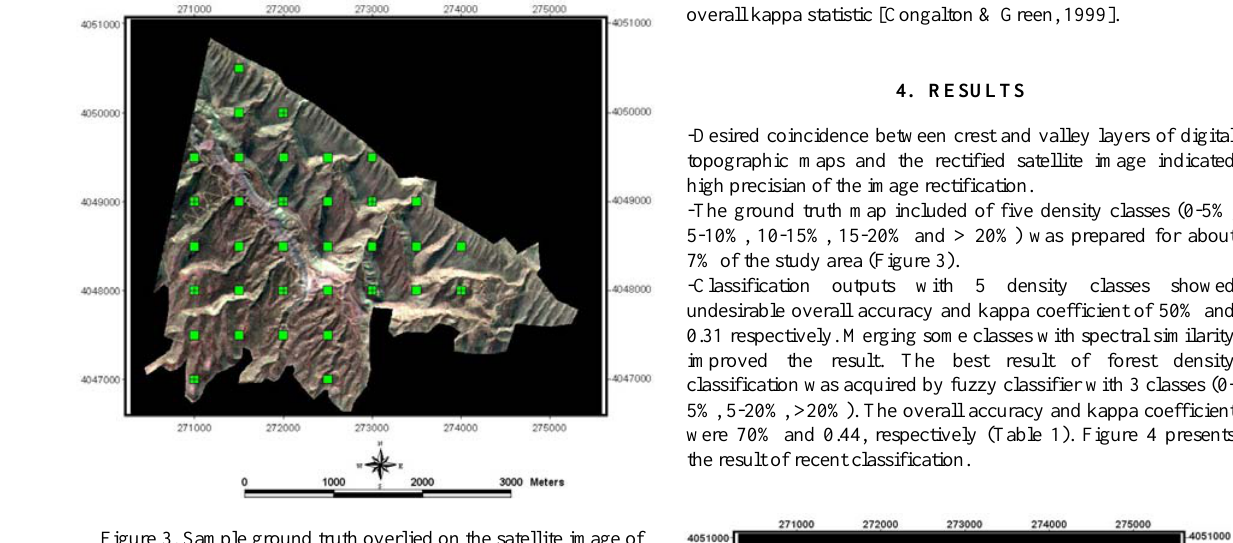
Figure 3. Sample ground truth overlied on the satellite image of the study area